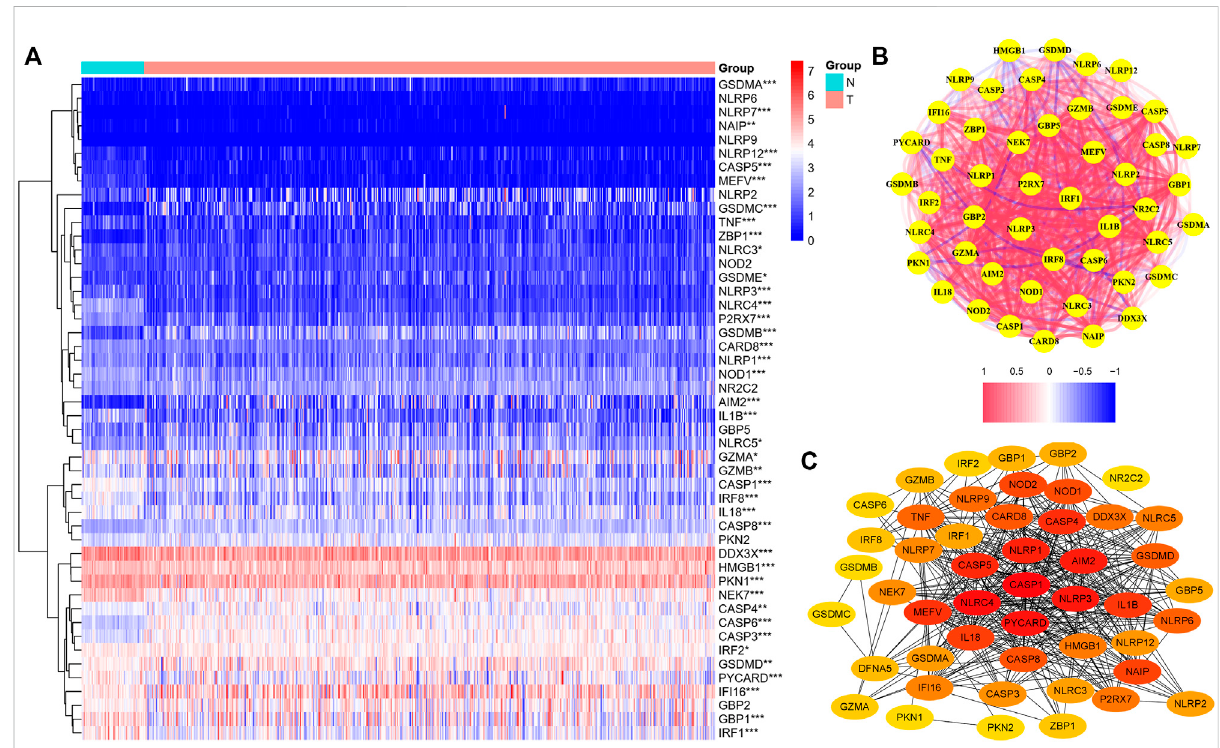
FIGURE 2 Expression of the 48 pyroptosis-related genes and the interactions among them. (A) Heatmap of the pyroptosis-related genes between the normal (N, brilliant blue) and tumor tissues (T, red). (wilcox.test, p values were as follows: ** p < 0.01; *** p < 0.001.) (B) PPI network showing the interactions of the differentially expressed pyroptosis-related genes (red line: positive correlation; blue line: negative correlation). (C) Correlation network of all the pyroptosis-related genes. The intensity of the colors re fl ected the strength of the